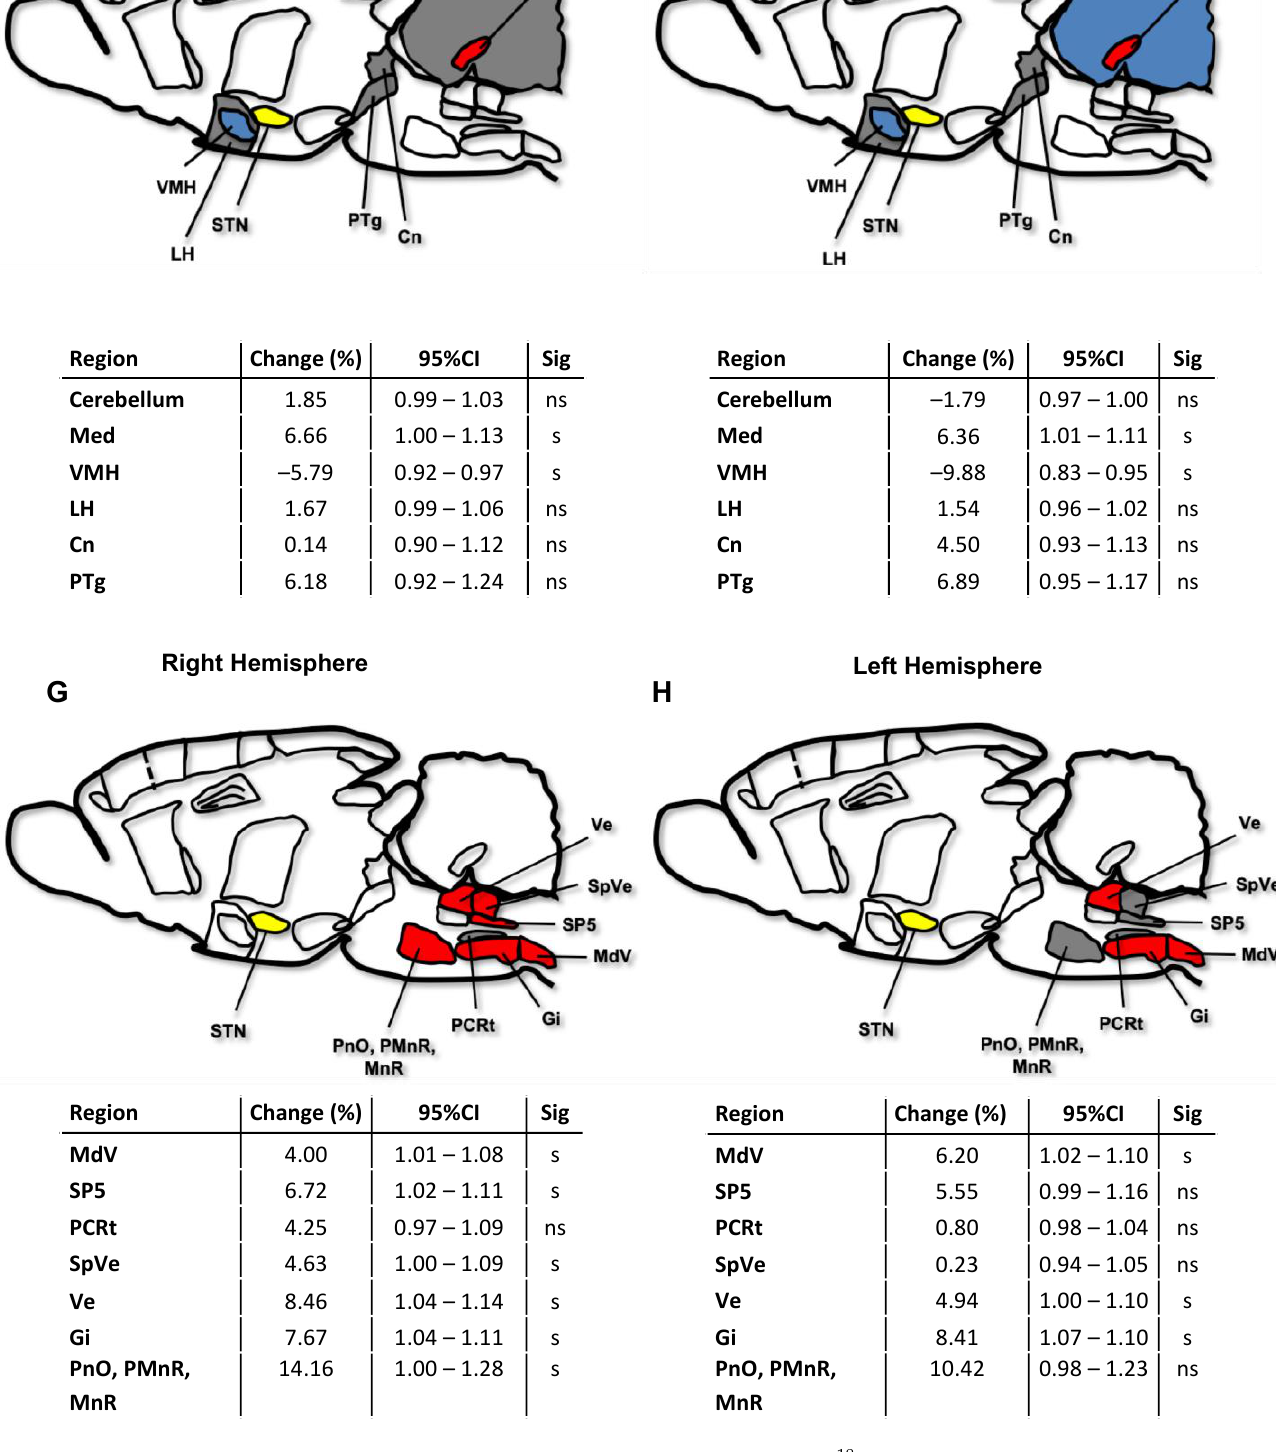
Figure 4. Changes in cerebral glucose metabolism ([ 18 F]FDG uptake) after STN-HFS compared to sham stimulation in rats with photothrombotic stroke. In the right hemisphere ( A ), STN-HFS